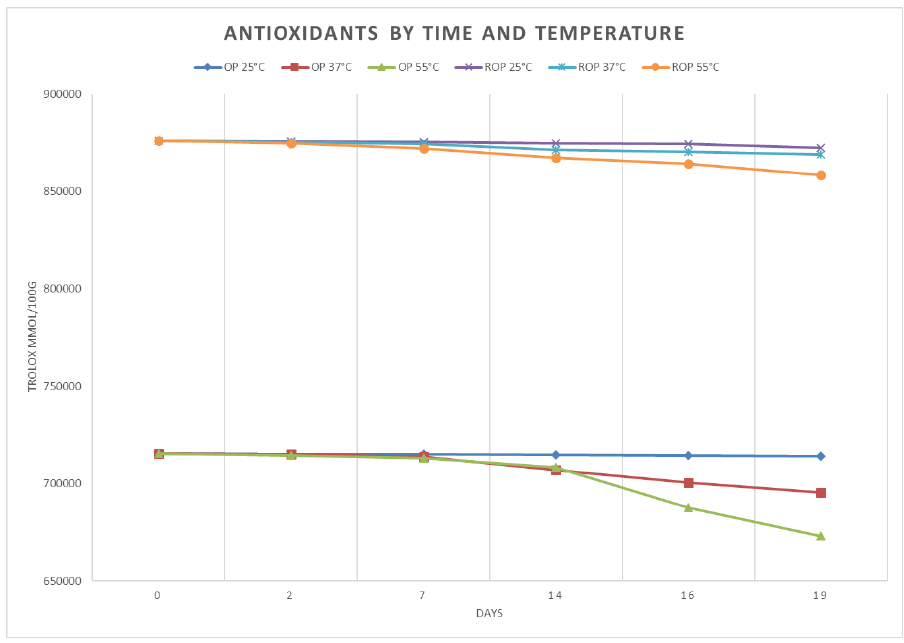
Figure 5. Results of the stress test for antioxidants.